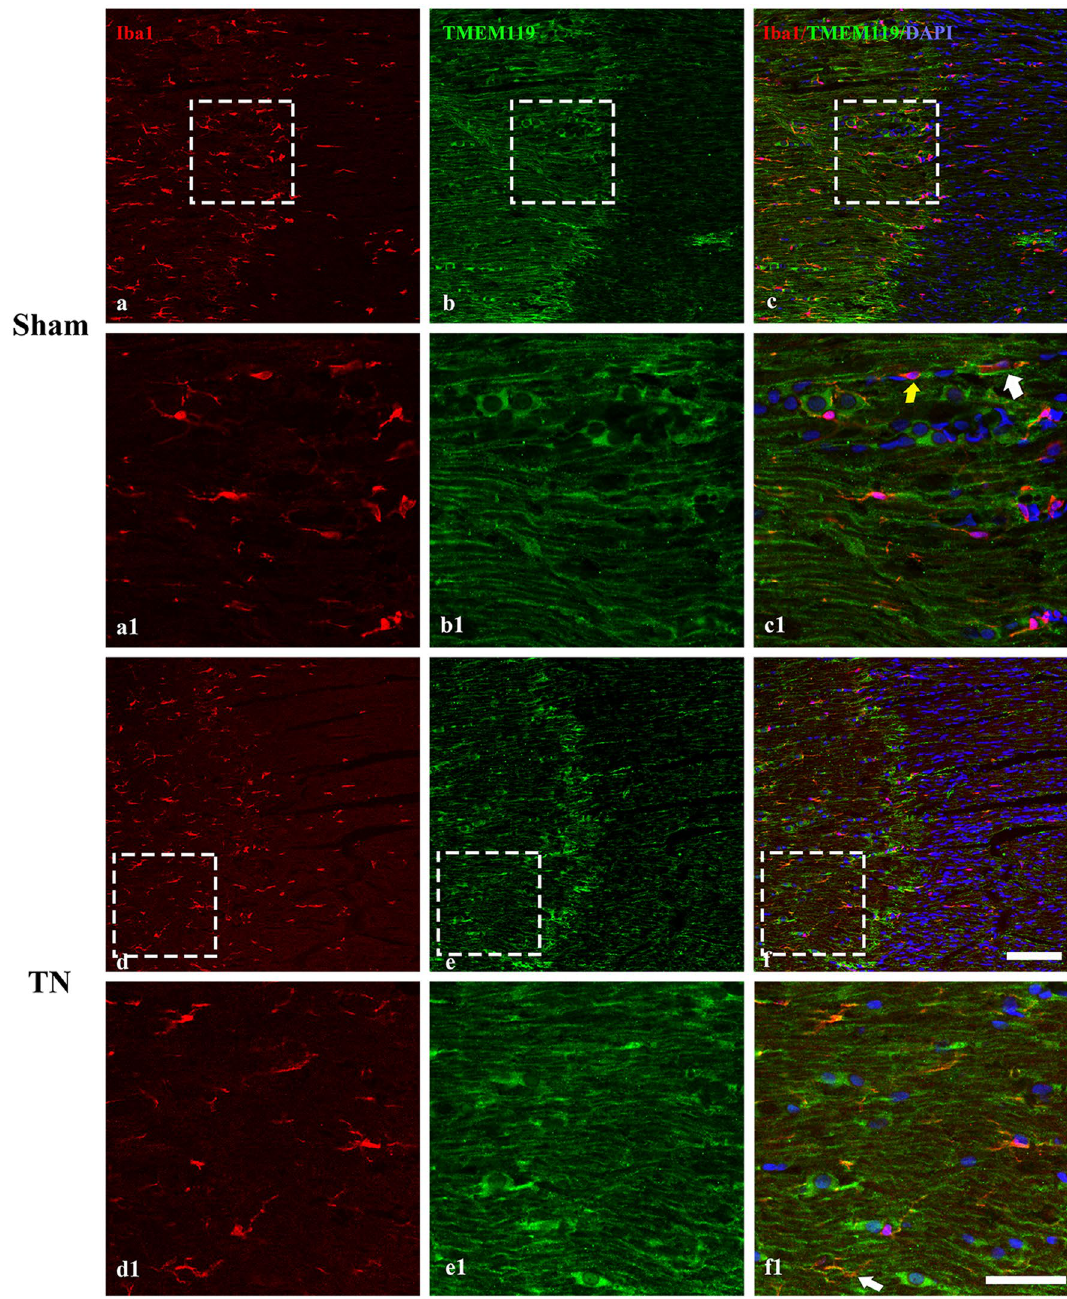
Figure 6. Immunofluorescence staining of Iba-1, TMEM119 and DAPI in the TREZ on POD 28. ( a – c ) and ( d – f ) show the expression of Iba-1 and TMEM119 in the TREZ in the sham group and the TN group; scale bar = 100 μm. ( a1 – c1 ) and ( d1 – f1 ) show the Iba-1 + /TMEM119 + cells (white arrow) and Iba-1 + /TMEM119 − cells (yellow arrow) in the TREZ, and there were also exited Iba-1 − /TMEM119 + cells; scale bar = 50